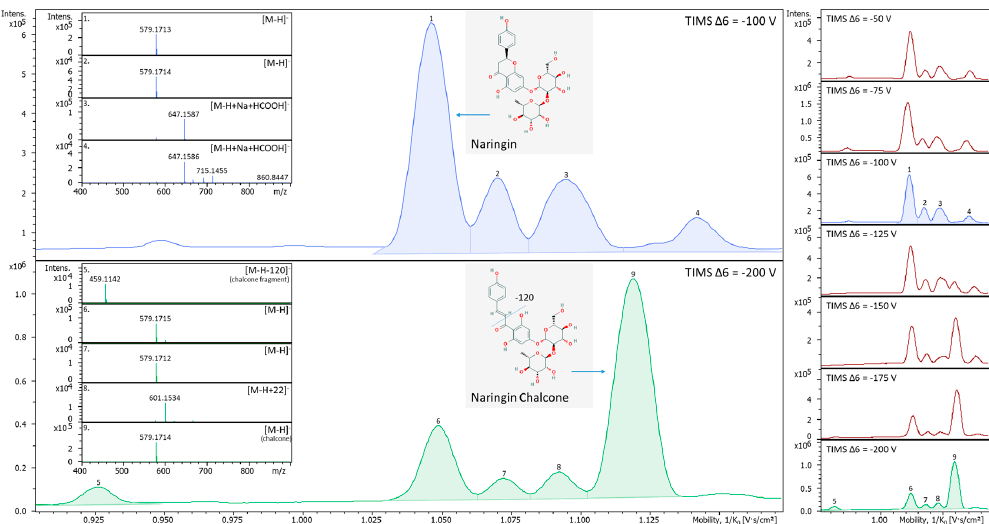
Figure 7. Variations in naringin ion mobility spectra and MS spectra with increasing TIMS ∆ 6 voltages (right part of the figure). At the default setting of − 100 V (blue trace, top left), there are at least four di ff erent ion species observed in the ion mobility spectrum indicated as peaks consisting of [M-H] − (peak 1), maybe a slightly larger or elongated conformer of [M-H] − (peak 2), and sodium plus formic acid adduct ([M-H + Na + HCO 2 − ] − , peaks 3 and 4. The trace also contained additional unknown peaks and a dimer that are not shown. A peak emerges at 1.119 1 / K 0 as the TIMS ∆ 6 voltage is increased from − 125 V gradually to − 200 V (Green trace, bottom left). Peak 9, shown in the green trace, is an ion that emerged with greater TIMS ∆ 6 voltage and was not found initially during the analyses. The new peak (peak 9) has been putatively annotated as naringin chalcone. A chain breakage of the naringin